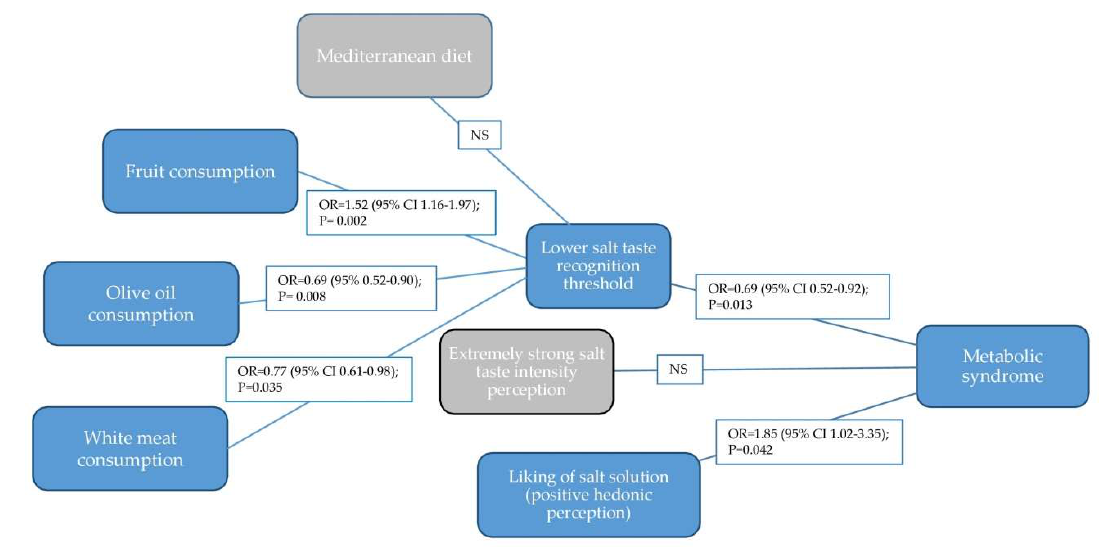
Figure 1. Pictorial presentation of the main findings of the study (results are from adjusted logistic regression model; NS - non-significant)